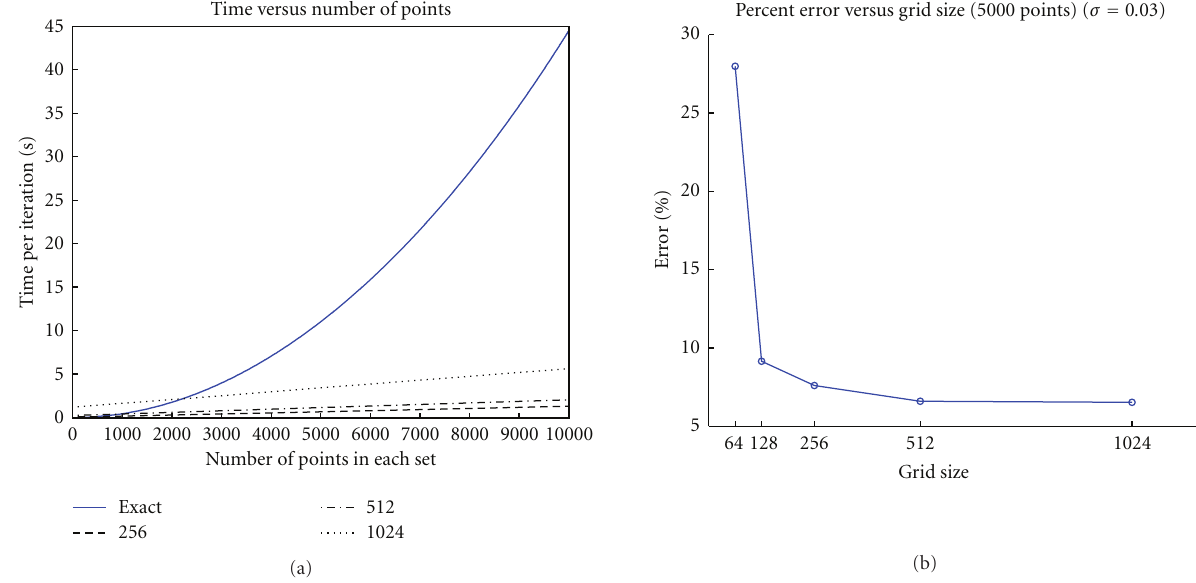
Figure 4: (a) shows the run time comparisons between direct computation and the particle mesh implementation for various grid size. Shown in (b) is the percent error for di ff erent for 5000 randomly generated points with di ff erent mesh sizes.